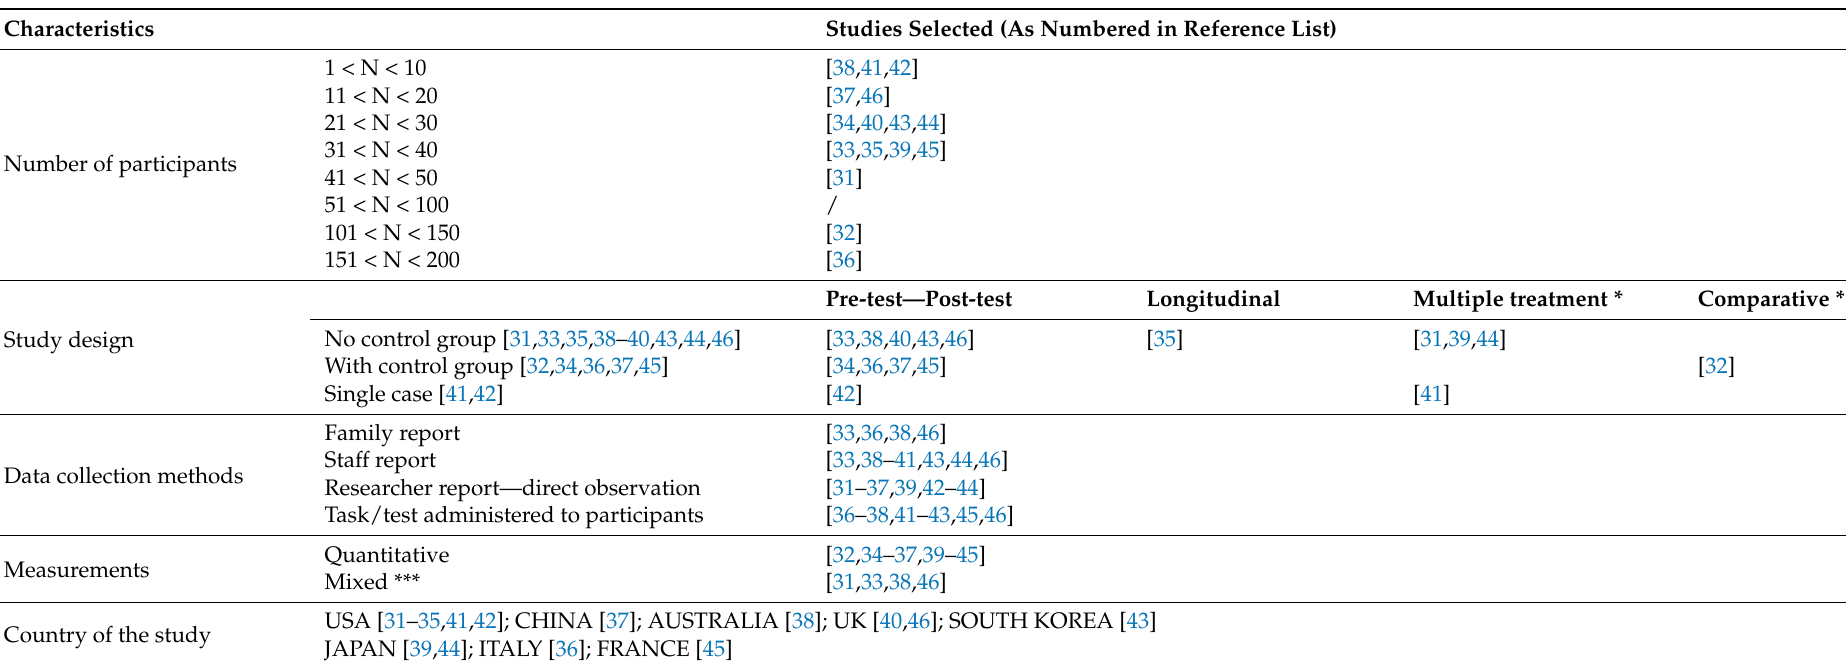
Table 1. Main characteristics of the